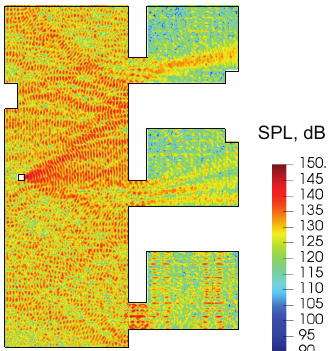
Figure 12. SPL distributions at 2 kHz calculated using PUFEM with C = 13.